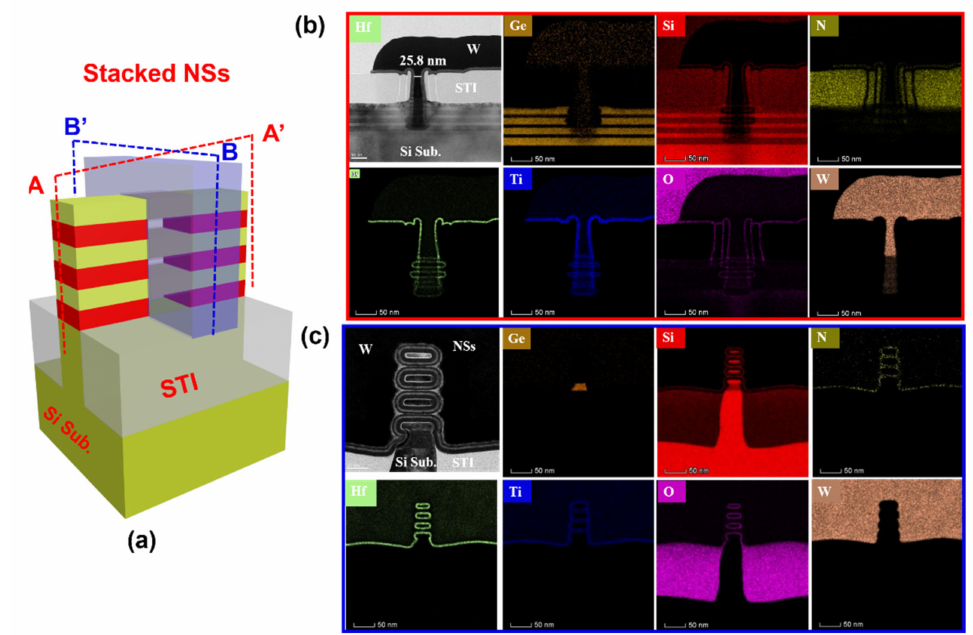
Figure 7. ( a ) A schematic of the stacked GAA Si NSs device, and ( b , c ) show cross-sectional TEM images along the direction of AA’ (cut across the fin top) and BB’ (cut across the channel direction), and the corresponding energy-dispersive X-ray spectroscopy (EDX) maps for Ge, Si, N, Hf, Ti, O and W distribution,